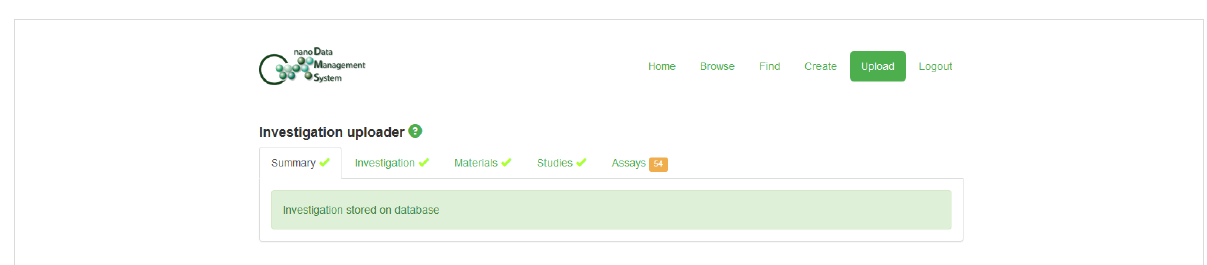
Figure 4: Confirmation that the “Toy Dataset” (Supporting Information File 3) was successfully uploaded: no error messages were generated by the internal ISA-TAB-Nano dataset validator and the warning messages regarding the position of the "Measurement Value [...]" and "Image File" columns reflect the addition of the “Measurement Value […]” column type to ISA-TAB-Nano, as compared to ISA-TAB, Assay files.